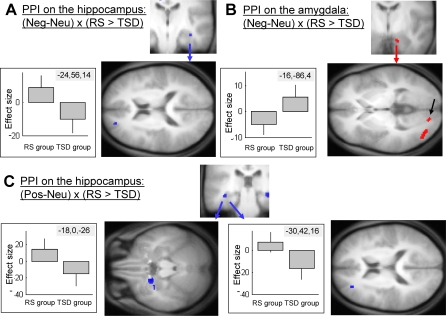
Psychopysiological Interactions(A and B) Regions more connected to seed areas [(A) right hippocampus, (B) amygdala] for negative than neutral correctly remembered pictures (inset: enlarged prefrontal region in a representative subject). (C) Regions are more connected to the left hippocampus for positive than neutral correctly remembered pictures.